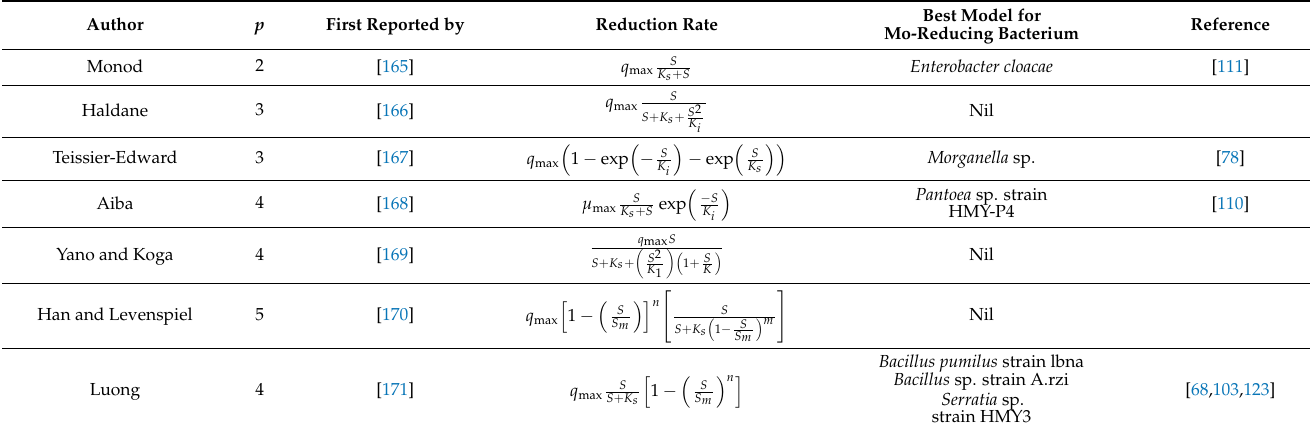
Table 3. Various mathematical models developed for degradation kinetics involving substrate